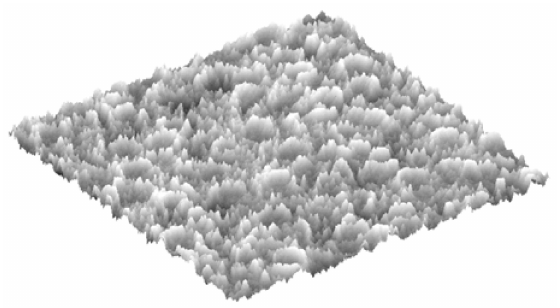
Figure 9. Optical approximation of the 3D topography of the example image of size 0.8 mm 2